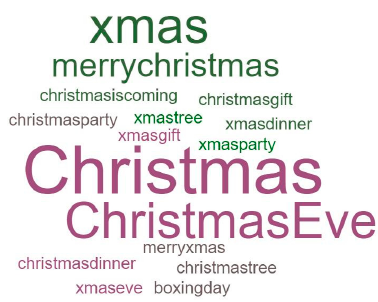
Figure 10. The word cloud for representative hashtags of the ’Christmas’ community.